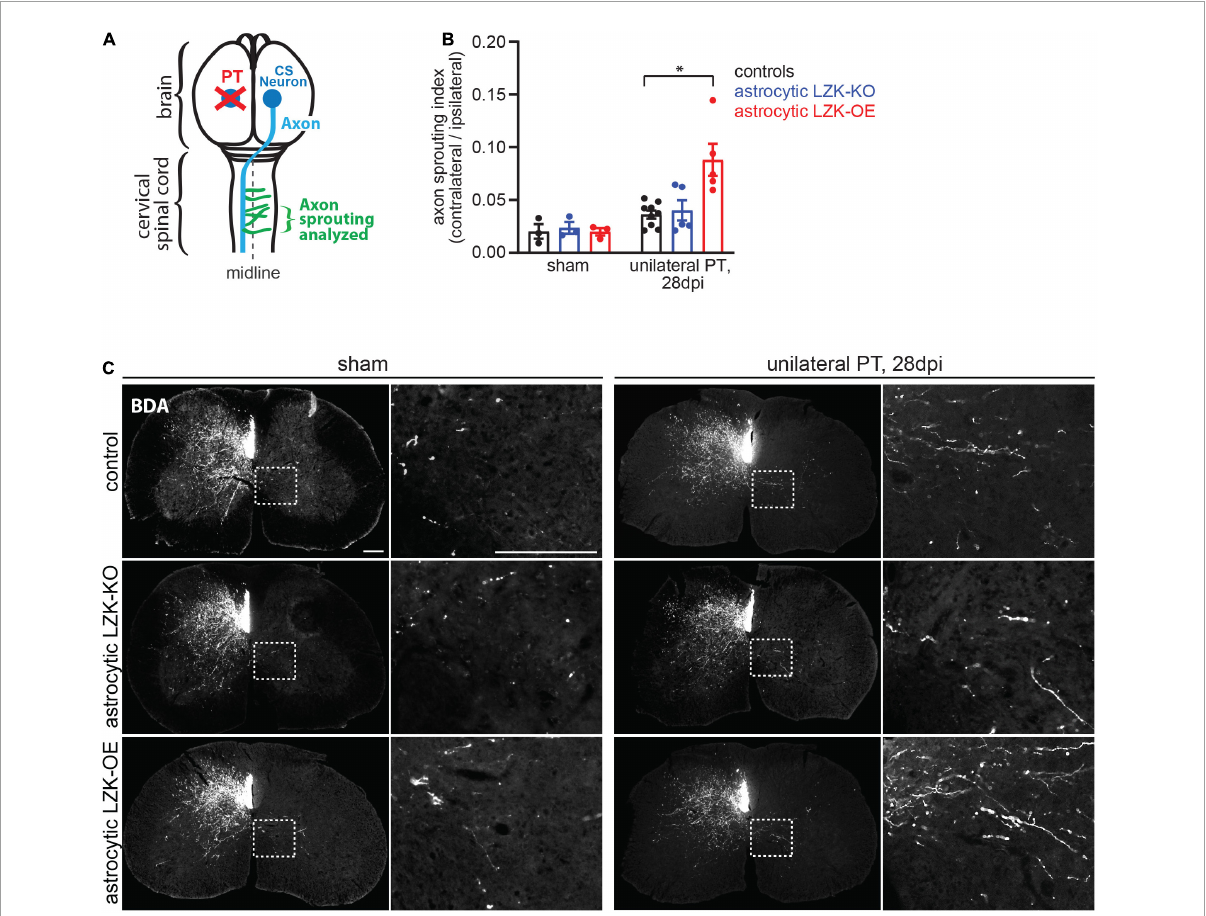
FIGURE3 LZK overexpression in astrocytes enhanced CST axon sprouting. (A) Diagram shows sprouting of intact CST axons (green) that cross the midline (dotted line) in the spinal cord, following unilateral PT (red X) to the forelimb sensorimotor cortex. Tissues from the cervical spinal cord at C7 were used to analyze CST axon sprouting. (B) Quantification of CST axon sprouting density index (contra-lesional/ipsi-lesional) in the indicated tamoxifen treated groups. n = 3 per group without injury; n = 5–9 per group 28 days after unilateral PT; graphing group mean with SEM. By two-way ANOVA, p < 0.05 for main injury effect and genotype effect, p < 0.05 for interaction between the two variables. Asterisk ( ∗ ) on graph indicates p < 0.05 for post-hoc comparison between genotype control and GFAP-CreER T2 ; LZK OE mice on 28 dpi with Bonferroni correction. (C) Biotinylated dextran amine (BDA) was injected into the uninjured cerebral cortex to label intact CST axons in the cervical spinal cord in the indicated tamoxifen treated groups, without or after unilateral PT. Dotted box outlines area magnified in adjacent image to show CST axon sprouting across the midline into the denervated gray matter, quantified in panel (B) . Scale bar represents 200 µ m in both low and high magnification